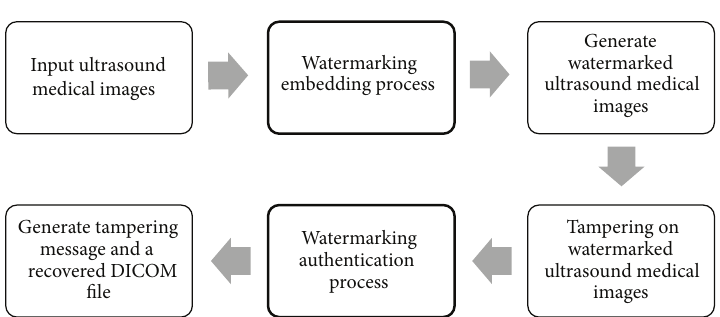
Figure 3: Watermarking process flow on a single frame of ultrasound medical